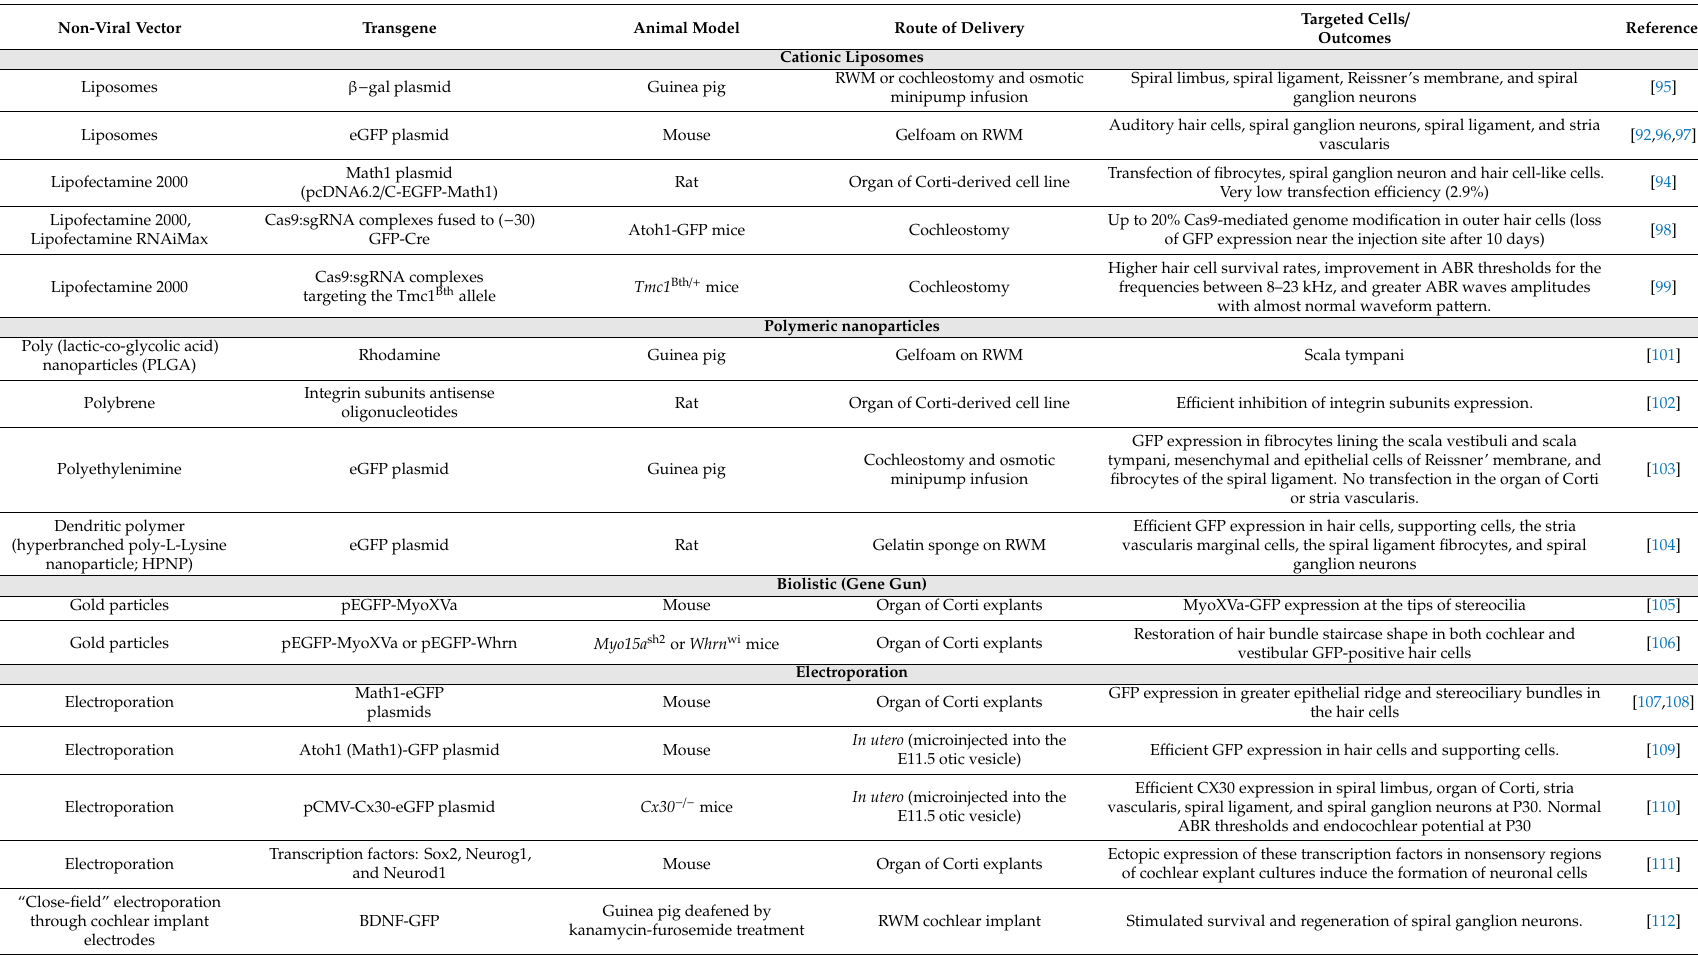
Table 2. Non-viral vectors used for inner ear gene